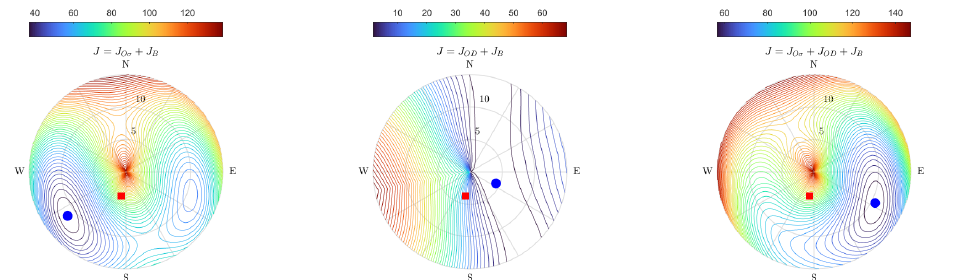
Figure 5. Illustration of the terms of the cost function with respect to wind vector. Blu lines indicate the lower value of the cost function J , blue circles indicate the higher likelihood of the solution for the wind, and red squares the a priori (model). The three panels refer to different definitions of J O